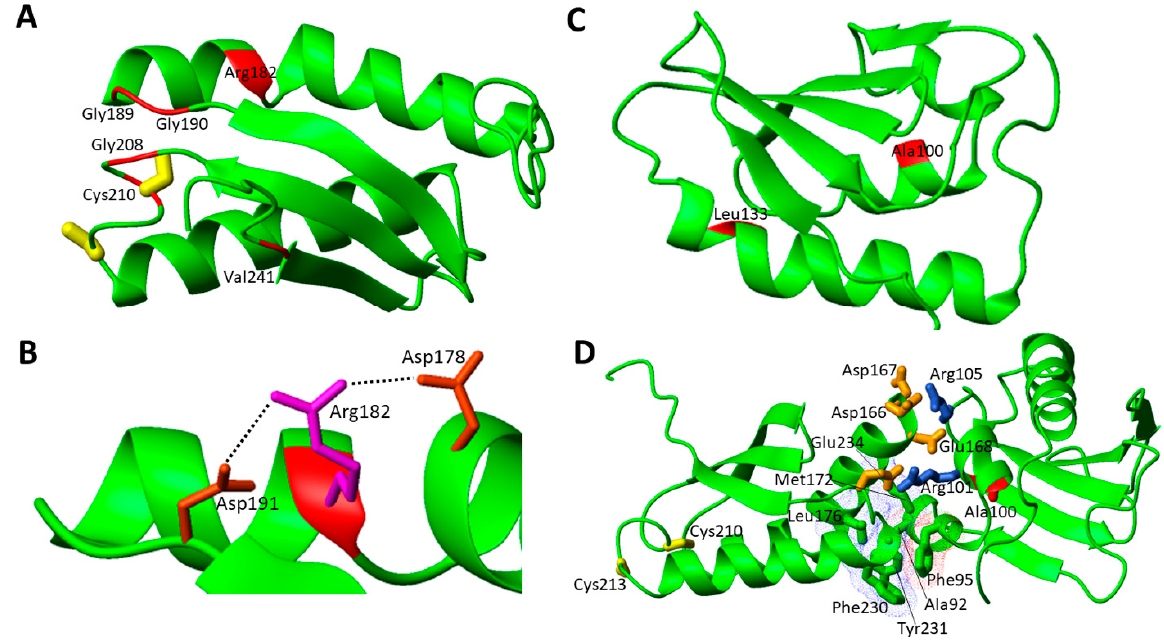
Figure 3. Pathogenic missense mutations mapped on the solution structures of the isolated N- and C-terminal domains of human NFU1 and on a structural docking model describing their interaction. ( A – C ) The backbone of the residues involved in pathogenic missense mutations in the C-terminal ( A ) and N-terminal ( C ) domains of NFU1 is shown in red on the ribbon structures of these domains (PDB ID 2LTM and 2M5O, respectively). The sidechains of the two conserved cluster coordinating Cys residues on the C-terminal domain of NFU1 are shown in yellow. ( B ) The electrostatic interactions established by sidechain of Arg182 (magenta) and the sidechains of the surrounding Asp residues (in orange) are shown as dotted black lines. ( D ) Docking structural model of the interaction between the N-terminal and C-terminal domains of NFU1 is shown. Ala100 of the N-terminal domain (in red) is close to Arg101 and Arg 105 (both in blue), which are in turn involved in electrostatic interactions with Glu and Asp residues of the C-terminal domain (all in orange). Interacting hydrophobic patches between the two domains (Van der Waals surfaces are in blue and red for the C- and N-domains, respectively), which involve both aromatic and aliphatic residues (sidechains are in green) and are close in space to Ala100 (sidechain is in red), are also shown. The c.545G > A (p.Arg182Gln) pathogenic missense mutation was found in two cases.